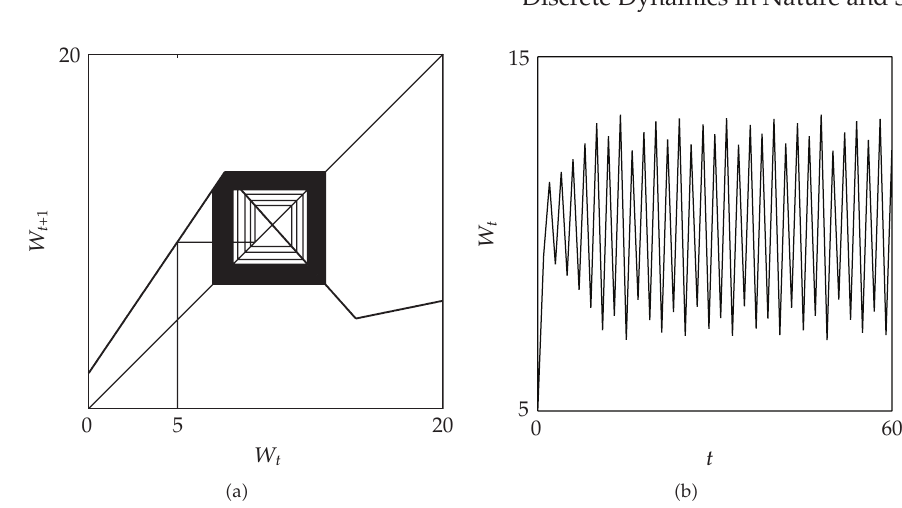
Figure 5: (cid:3) a (cid:4) The generic aperiodic orbit covers two disjoint invariant sets. (cid:3) b (cid:4) The trajectory with respect to time. In both cases μ (cid:7) 5 . 5 and W 0 (cid:7)